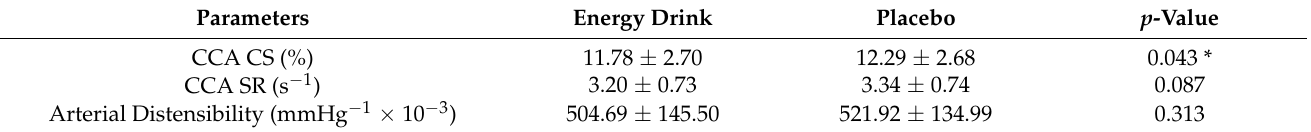
Table 3. CS, SR and, Arterial Distensibility after Energy Drink and Placebo Consumption ( n = 27).